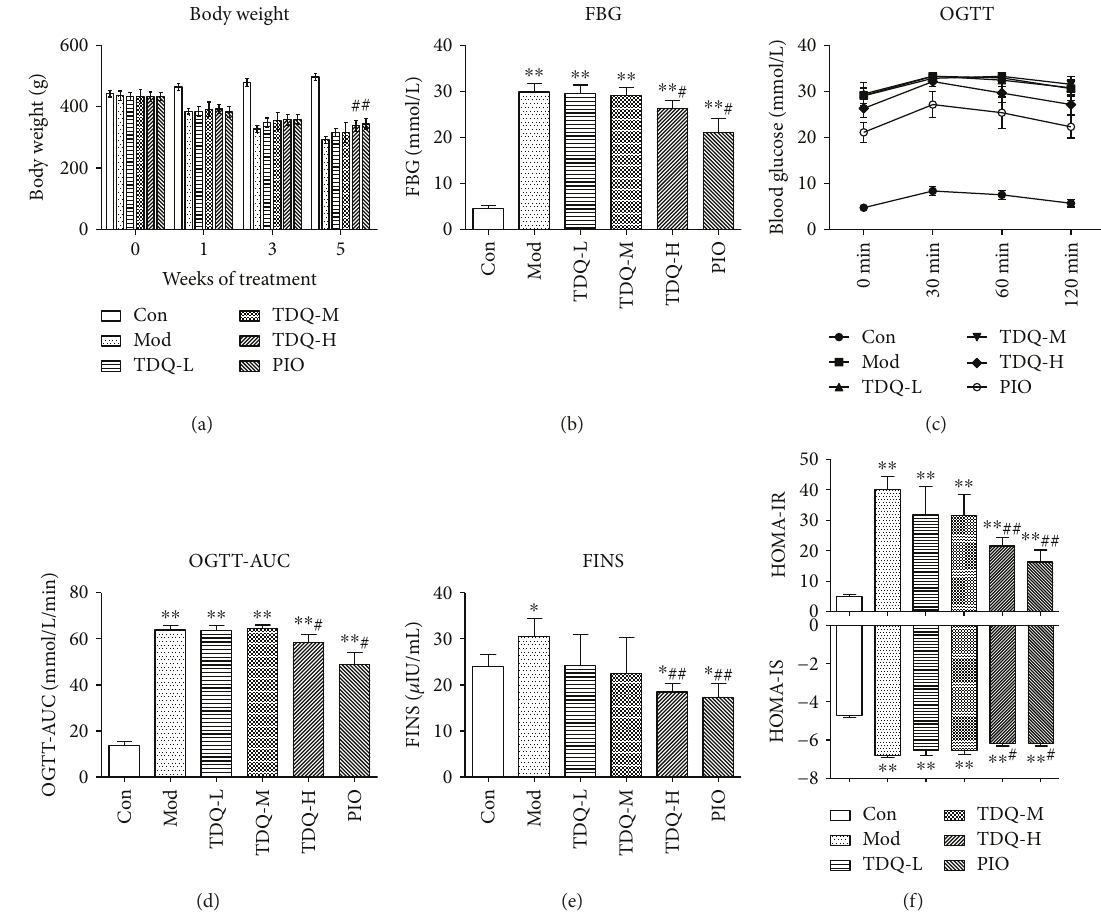
Figure 1: TDQ mitigated the insulin resistance of type 2 diabetic rats. (a) Body weight over time in each groups. (b – d) Fasting blood glucose (FBG) and oral glucose tolerance tests (OGTT) and area under the curve (OGTT-AUC) were calculated in rats at the end of the 5-week experimental protocol. (e, f) Circulating insulin (FINS), calculated HOMA-IR, and HOMA-IS in each group. Results are shown as the mean ± SD . ∗ P < 0 05 and ∗∗ P < 0 01 vs. Con; # P < 0 05 and ## P < 0 01 vs Mod. Con: control group, Mod: model group, TDQ: Tangduqing granules, PIO: pioglitazone